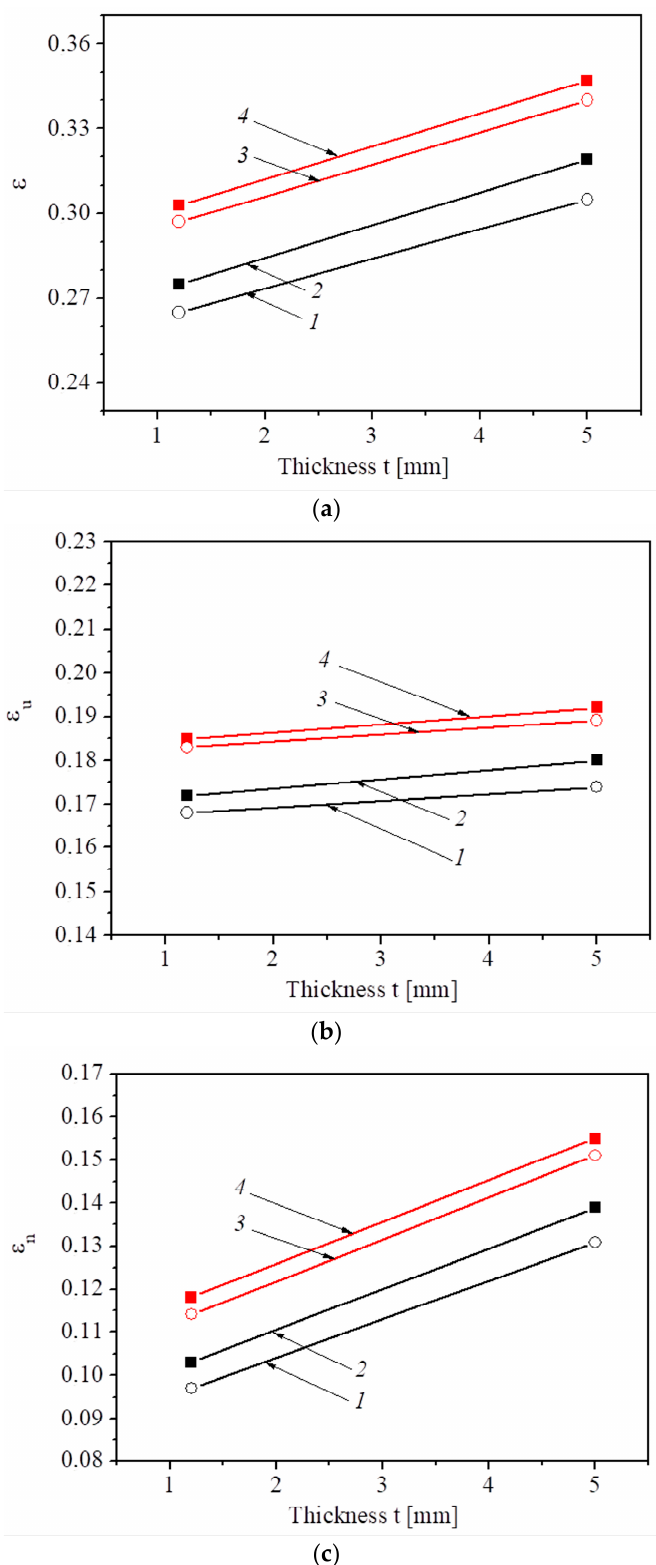
Figure 8. The average total elongation ( a ), uniform elongation ( b ), and non-uniform elongation ( c ) of steel A ( 1 , 2 ) and B ( 3 , 4 ) determined using specimens of transverse ( 1 , 3 ) and longitudinal ( 2 , 4 ) orientation.